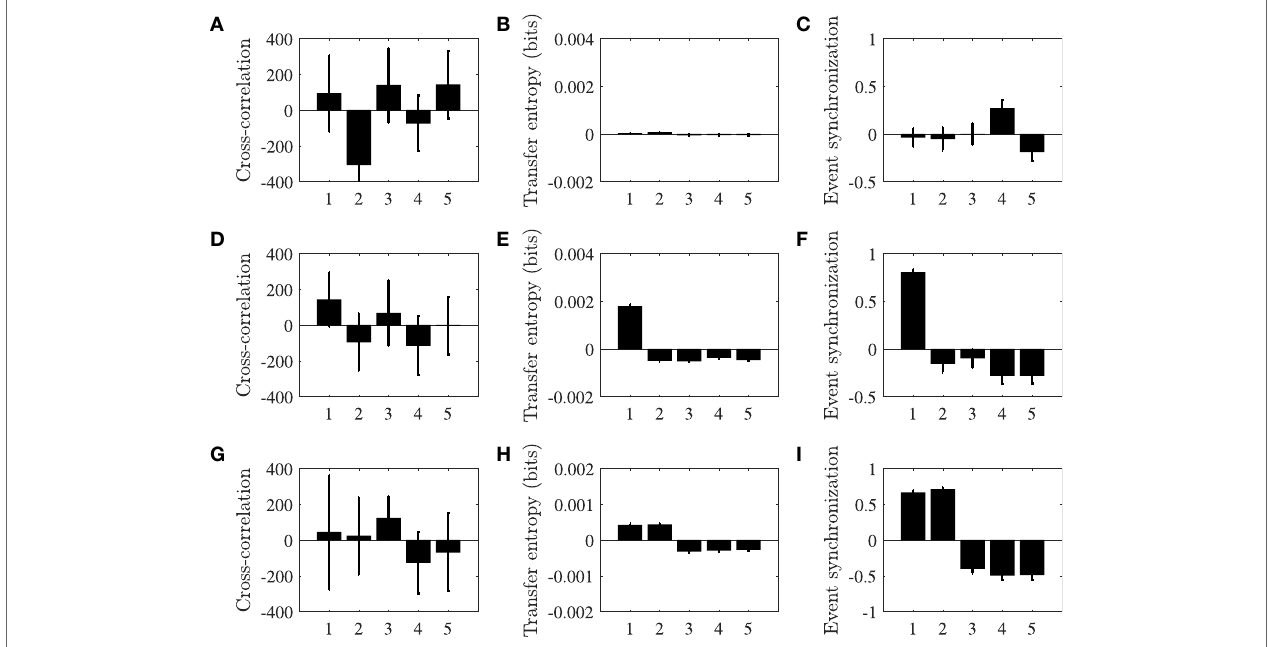
FIGURE 3 | Classification index CL i , for particles i = 1 ;:::; N computed for cross-correlation (A,D,G) , transfer entropy (B,E,F) , event synchronization (C,F,I) , without leader (A–C) , with one leader (D–F) , and with two leaders (G–I) . Each simulated group includes five identical particles ( i = 1 ;:::; 5), and the Vicsek model parameters are set to v = 0.01, r = 0.23, and (cid:17) = 0.21. Each bar refers to the mean value of the classifier across 30 simulations, and the error bar is one standard deviation. The numbering of particles that are not leaders is arbitrary, such that in panels (D–F) particle 1 is the leader and in panels (G–I) particles 1 and 2 are leaders.